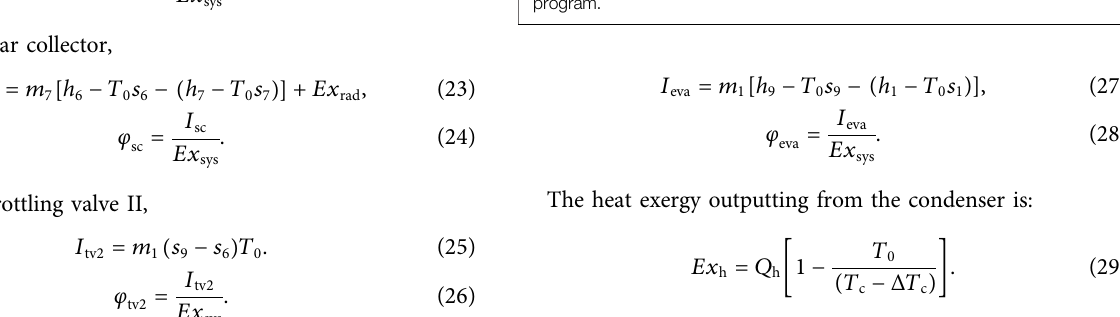
FIGURE 2 | Flowchart for the calculation procedure of the simulation